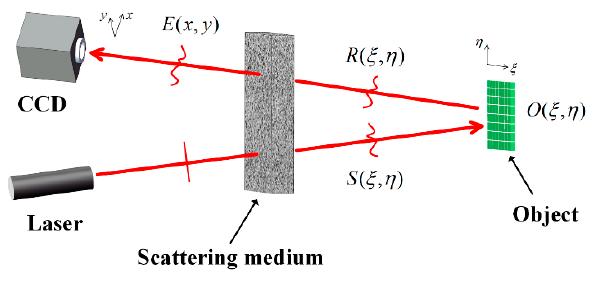
Figure 1. Schematic of imaging an object hidden behind a scattering medium.